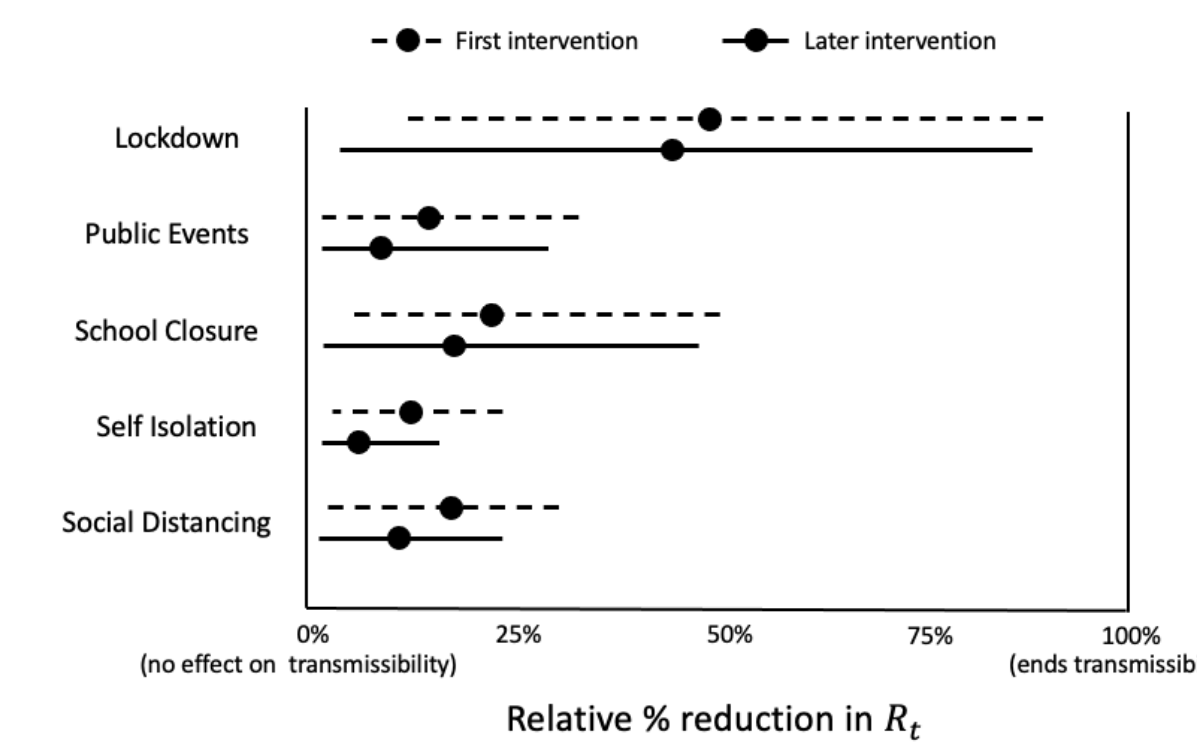
Figure 2. Impact on model outputs according to covariates from government interventions